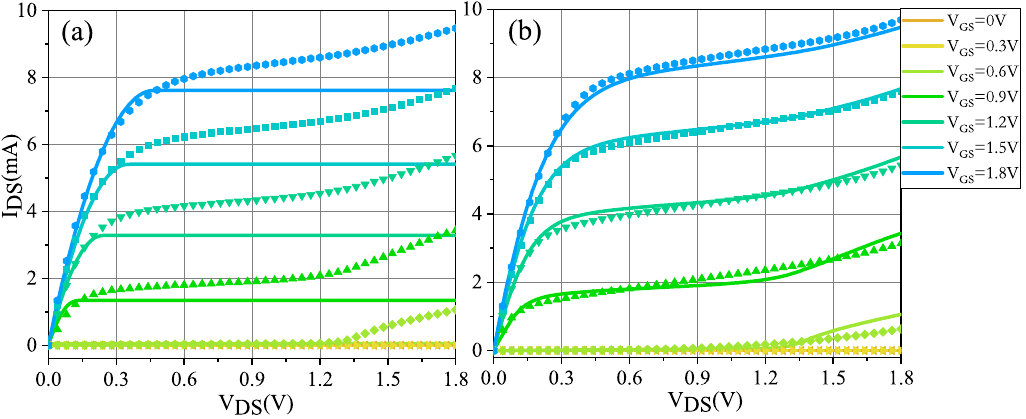
Figure 3. Spice model fitting, ( a ) kink effect, ( b ) the modified spice model.